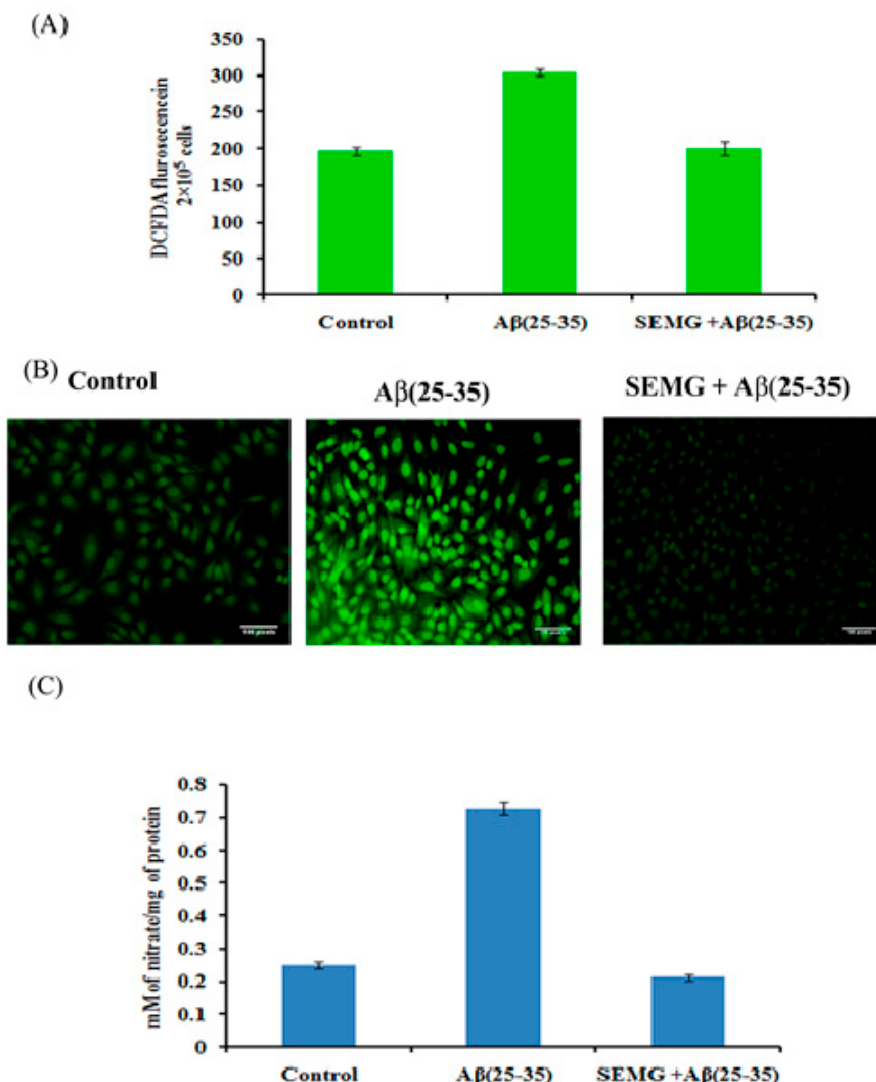
Figure 7. ( A ) Measurement of ROS level in cells exposed to A β (25–35) co-treated with SEMG by spectro fluorimetric analysis; ( B ) Fluorescence microscopic images of Neuro2A cells illustrating intracellular ROS level with 20 × magnification; ( C ) RNS scavenging effect of SEMG in cells treated with A β (25–35). Data are expressed as Mean ± SD of triplicate assays.